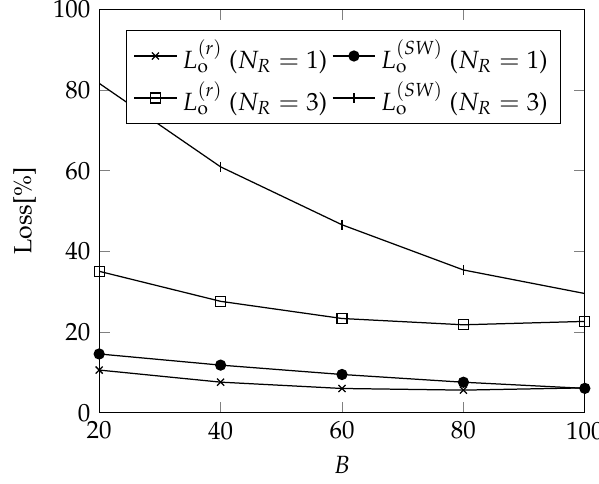
Figure 2. MNO’s loss.